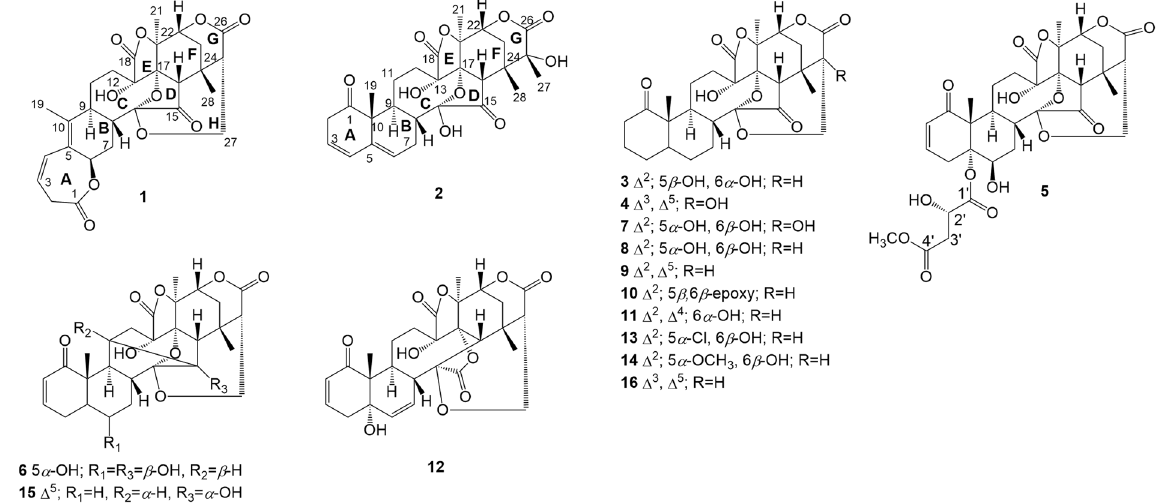
Figure 1. Chemical constituents of P . angulata